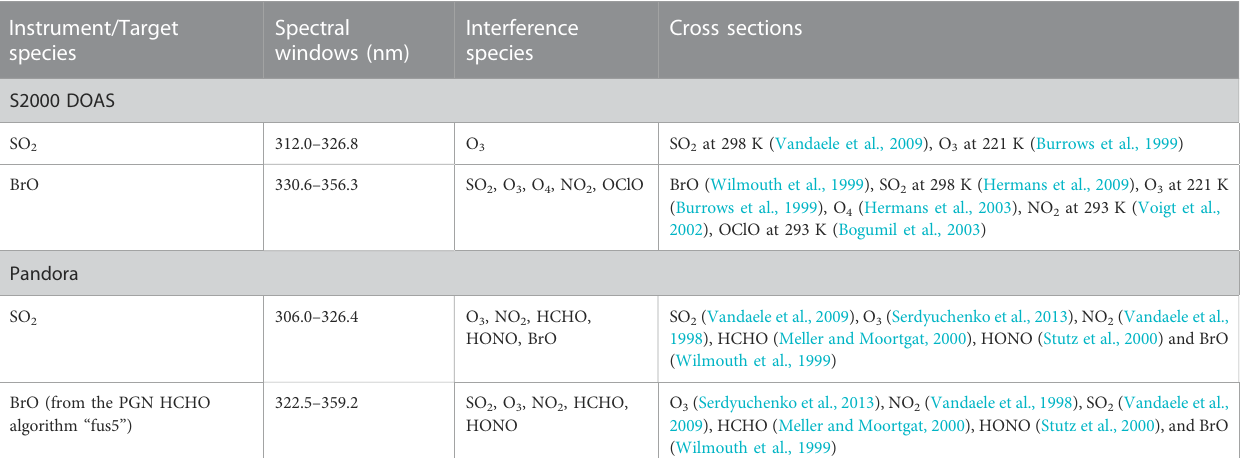
TABLE 1 Retrieval settings used for the S2000 DOAS and Pandora spectra